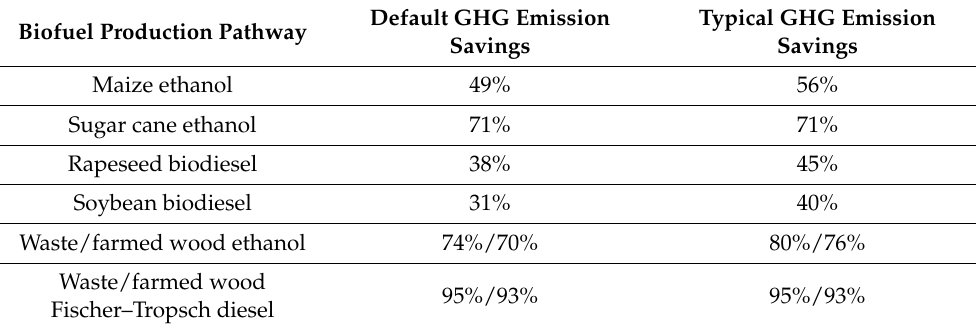
Table 3. GHG impacts of biofuels.